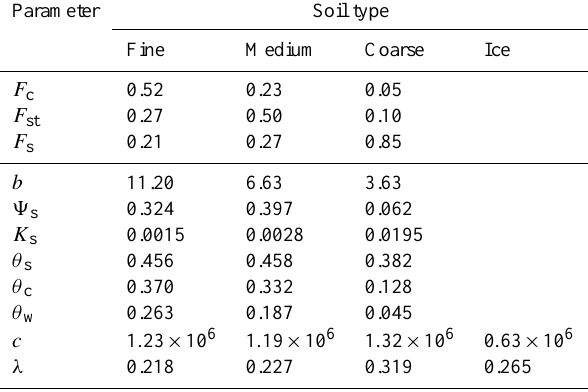
Table 1. JULES soil parameter values for fine, medium and coarse soil used in the Brooks and Corey (1964) soil hydrology scheme. F c is clay fraction; F st is silt fraction; F s is sand fraction, all dimen- sionless; b is the Brooks-Corey (or Clapp-Hornberger) exponent in soil hydraulic characteristics (–); 9 s is the absolute value of the soil matric suction at saturation (m); K s is the hydraulic conductivity at saturation (kgm − 2 s − 1 ) ; θ s is volumetric soil moisture content at saturation (m 3 water per m 3 soil); θ c is the volumetric soil moisture